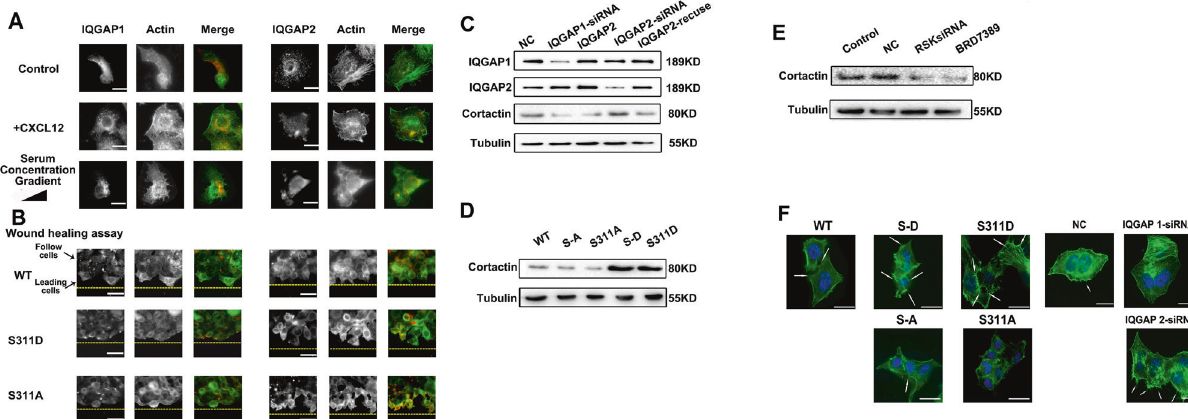
Fig. 7 IQGAP 1 location regulates cortactin-associated formation of fi lopodia and lamellipodia. A Representative images of MF and IQGAP1 or IQGAP2 distribution in the directional migration model or after CXCL12 treatment. (green, FITC-stained MFs; red, TRITC-stained IQGAP1/IQGAP2), scale bar, 10 μ m. B Representative images of MF and IQGAP1 or IQGAP2 distribution in the wound healing assay. (green, FITC-stained MFs; red, TRITC-stained IQGAP1/IQGAP2), scale bar, 10 μ m. C Western blotting analysis of Cortactin, IQGAP1, and IQGAP2 levels